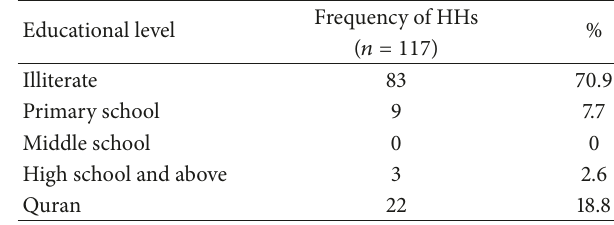
Table 1: Sex distribution and marital status of the respondents in the study area.